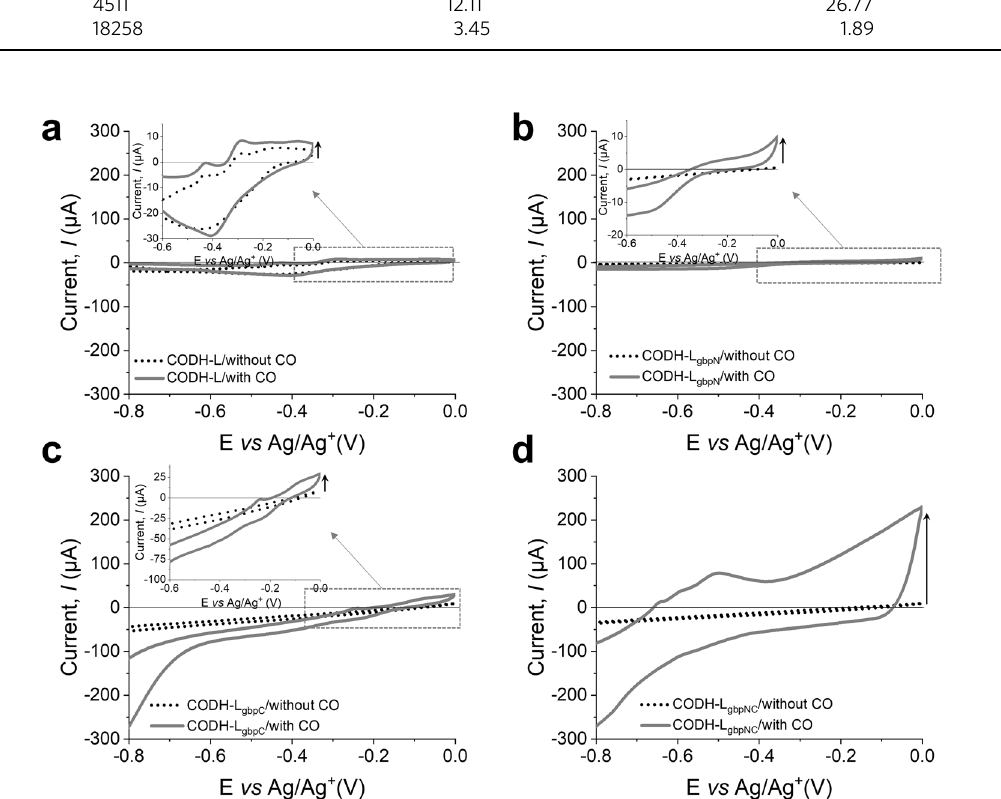
Fig. 6 Cyclic voltammetry pro fi les of the native and synthetic enzymes. Representative CV pro fi les of a the native CODH-L, b CODH-L gbpN , c CODH- L gbpC , and d CODH-L gbpNC when immobilized on the SPGE in the presence and absence of CO (at a scan rate 100 mV s − 1 ).